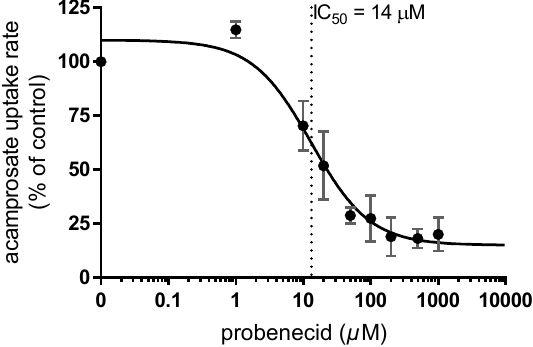
Figure 7. OAT1-mediated acamprosate uptake with increasing concentrations of probenecid (0.02– 1022 µM). The uptake of 200 µM acamprosate in HEK293-Flp-In OAT1 cells was measured in buffer pH 7.4. Data are expressed as % of uptake rate (pmol·mg protein -1 ·min -1 ) of acamprosate without inhibitor (control). Each data point represents the mean±SEM obtained in three cell passages obtained at Lab. 1.